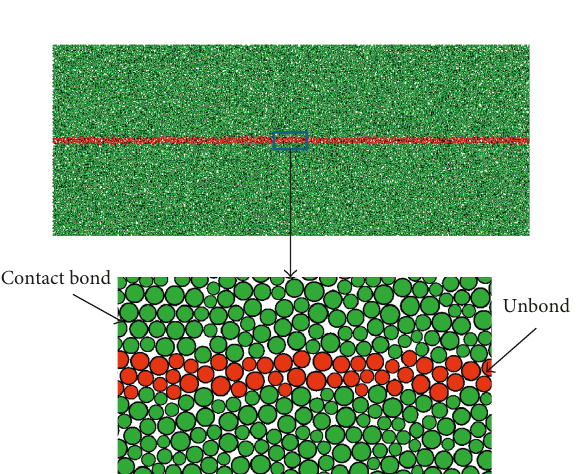
Figure 1: Schematic of a direct shear test.